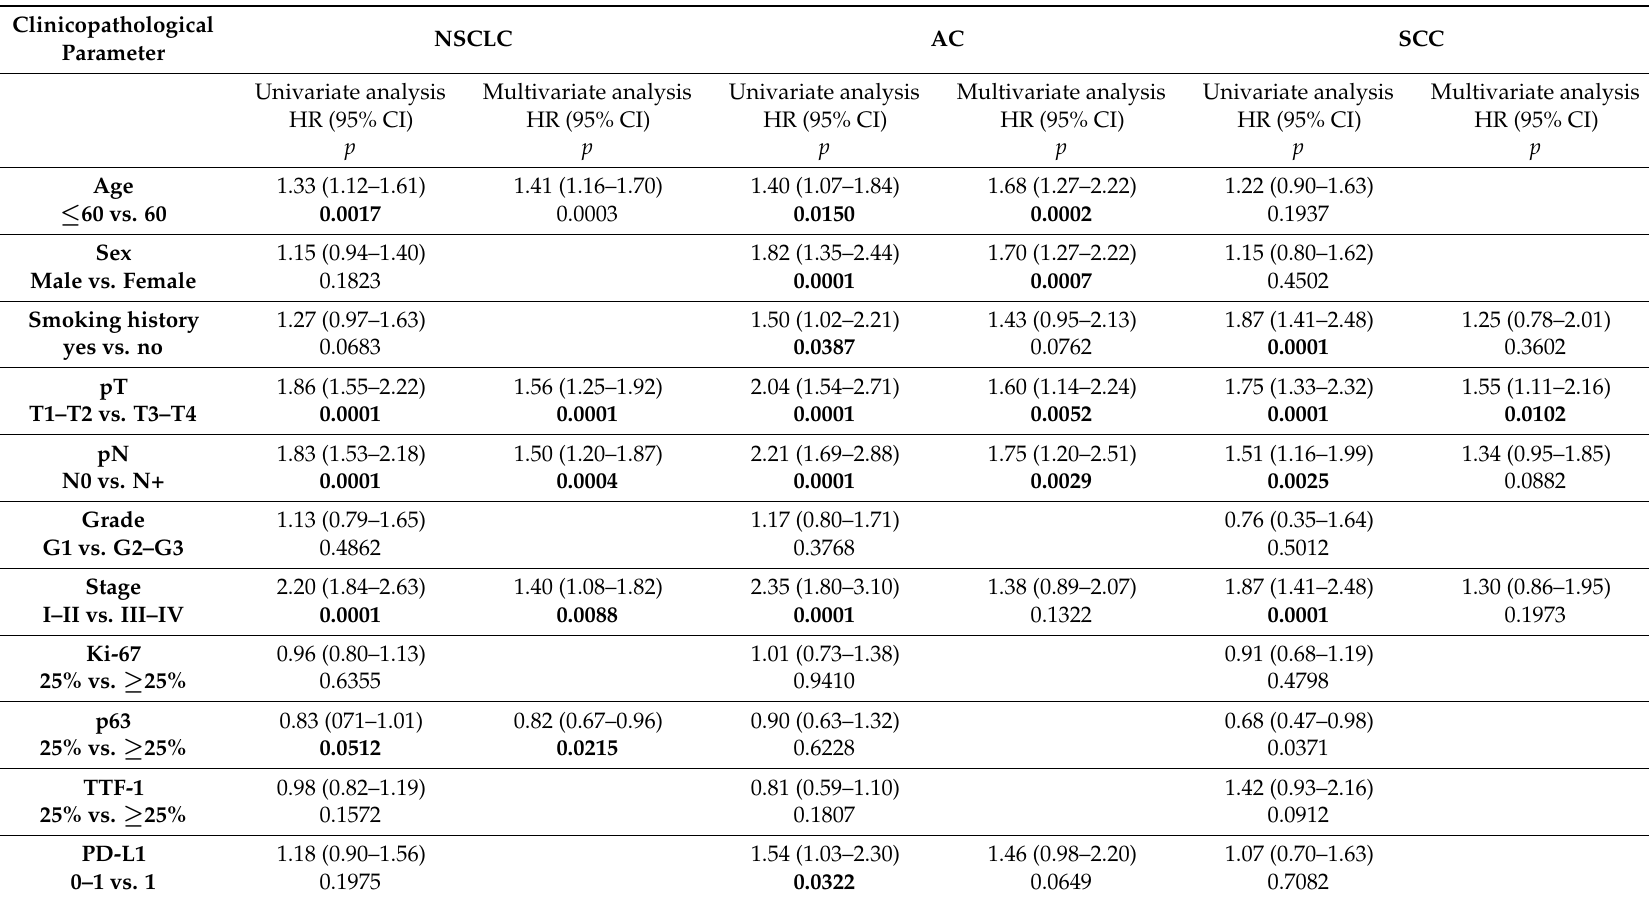
Table 3. Univariate and multivariate Cox proportional hazards analysis in 866 patients with NSCLC (344 AC, 381